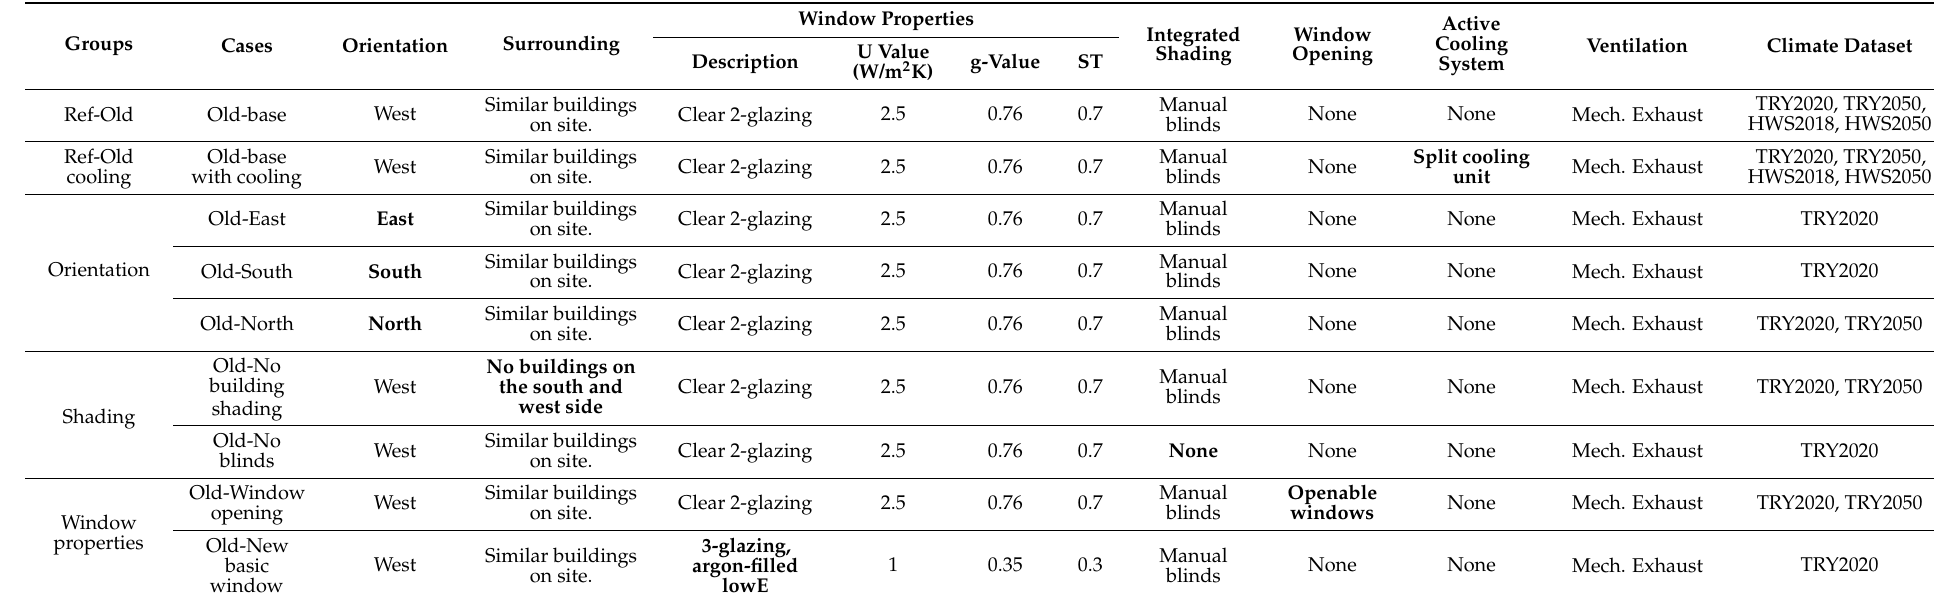
Table 3. Description of simulation cases in the old